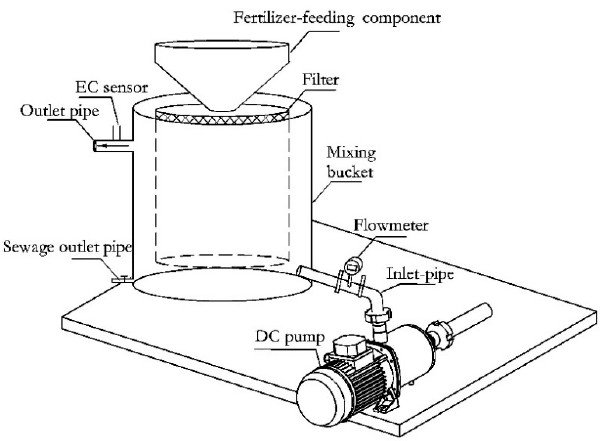
Figure 1. Schematic diagram of the fertigation device developed in the current study.